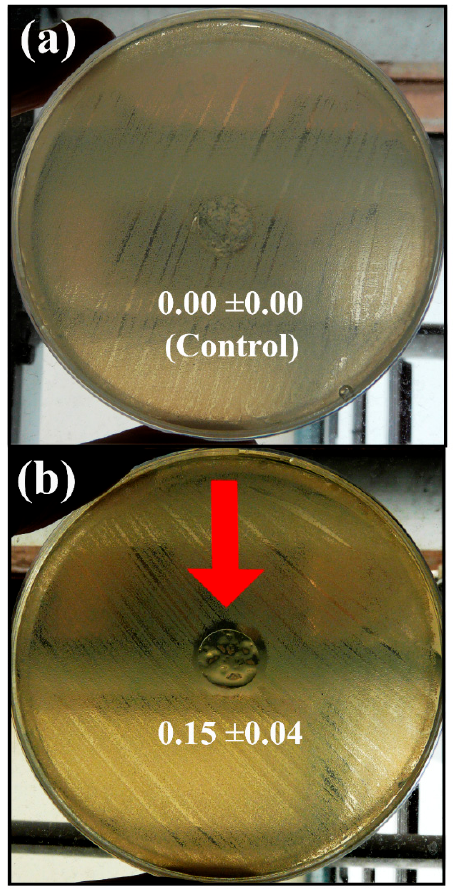
Figure 5. Antibacterial activity of the calcium alginate films without carbon nanofibers (control sample disk) ( a ) and calcium alginate/carbon nanofibers composite films ( b ) against multidrug-resistant Staphylococcus epidermidis by the agar disk diffusion test after 24 h of culture at 37 ◦ C. The red arrow indicates the sample disk showing antibacterial “halo” and normalised widths ( nw halo ) calculated with Equation (2) are shown for each image.